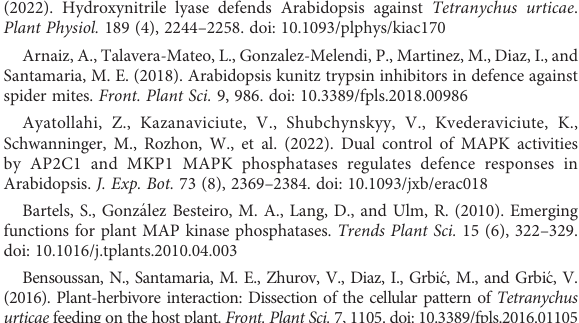
SUPPLEMENTARY FIGURE 1 Scheme of the position of the T-DNA insertions in the mutant lines. SUPPLEMENTARY FIGURE 2 Relative expression levels of MKK4 and MPK11 in WT and T-DNA inserted lines. Data are means ± SE of three biological replicates. Foliar damaged area quanti fi ed after 4 d of mite infestation. Data are mean ± SE of eight replicates. SUPPLEMENTARY FIGURE 3 Quanti fi cation of trypan blue staining after 24 h of mite infestation in Arabidopsis WT and T-DNA insertion lines for MAPKKK17 and MAPKKK21 . Data aremean ±SE of eight replicates. Different lettersindicate signi fi cant differences (P<0.05, One-way ANOVA followed by Student-Newman- Keuls multiple comparisons test). SUPPLEMENTARY FIGURE 4 Relative expression of MPK3 , MPK6 , and MPK4 genes in different Arabidopsis backgrounds. Gene expression was quanti fi ed by RT-qPCR after 1h, 3h, and 24h of mite feeding on WT and T-DNA mutant lines. Data are means ± SE of three biological replicates. Signi fi cant factors (SF) indicate whether the two independent factors, T (treatment with mites) and G (genotype), and/or their interaction, I (T×G), were statistically signi fi cant (Two-way ANOVA, P<0.05, followed by Student-Newman- Keuls multiple comparisons test). SUPPLEMENTARY FIGURE 5 Western blot analysis of MAPK activation after 1h, 3h, and 24h of mite treatment in WT and T-DNA mutant lines. Flagellin treatment was used as a control of band size for MPK3/4/6. Activated MAPKs were detected by immunoblots using a -p44/42-ERK antibody. Equal loading is indicated by the Ponceau S staining of Rubisco. SUPPLEMENTARY TABLE 1 Sequences of the oligonucleotides used in this work. SUPPLEMENTARY DATA SHEET 1 Lists of 100 most signi fi cant coexpressed genes to MAPKKK17 and MAPKKK21